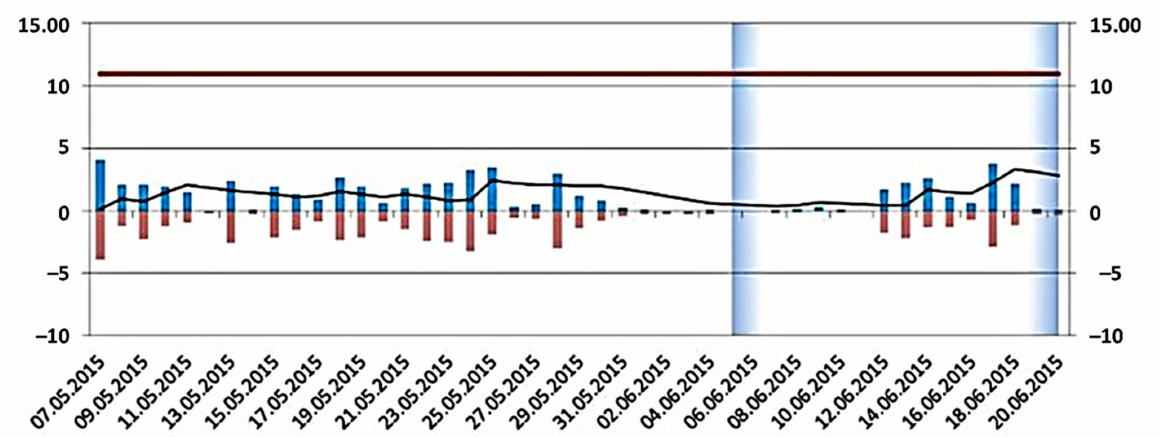
Figure 1. Water balance estimation for the example of the 2015 Louisiana flood. Blue bars refer to the whole volume of daily precipitation in the whole basin (summarized through regions) in units 10 9 m 3 ; red bars–the whole volume of daily evaporation + permeation in the whole basin (summarized throughout the region), 10 9 m 3 ; black line–the whole volume of accumulated water mass in the whole basin (summarized through regions), 10 9 m 3 ; red line–the maximum of observed water mass, 10 9 m 3 . On the vertical axis–the water level (10 9 m 3 ). On the horizontal axis–measurement days (date). Positive values–excess water mass compared to normal conditions, negative values–decrease compared to normal